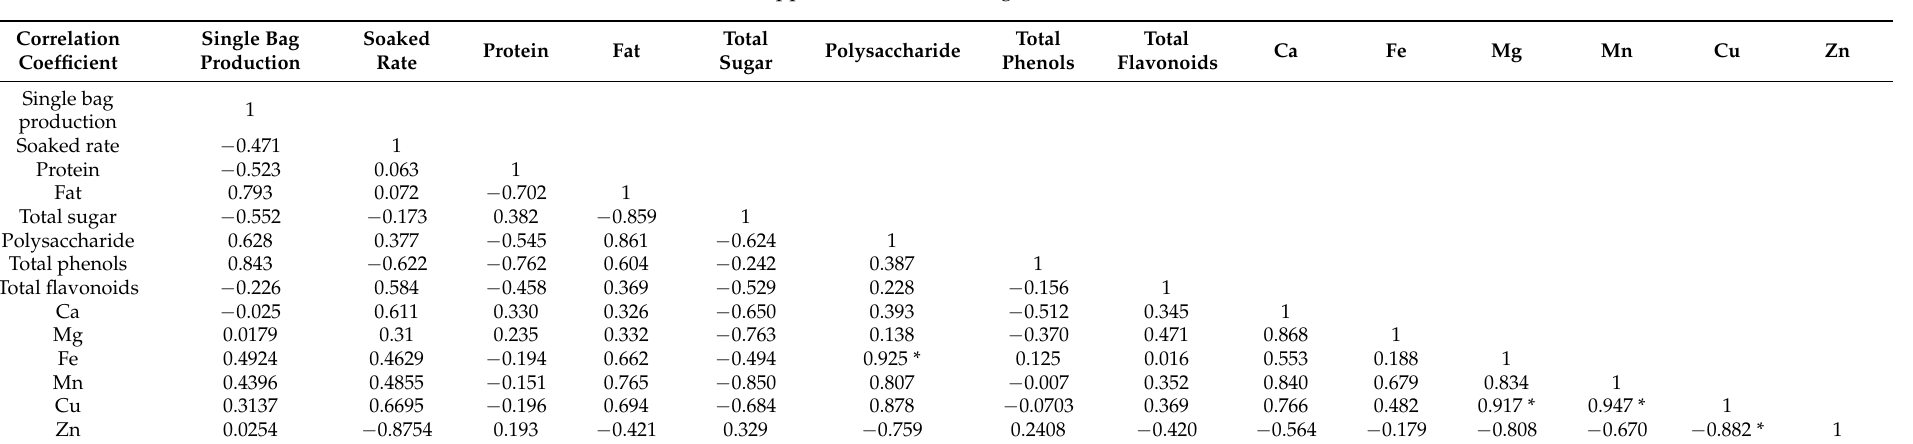
Table 4. Correlation between different walnut supplemental levels and growth index of A. auricula